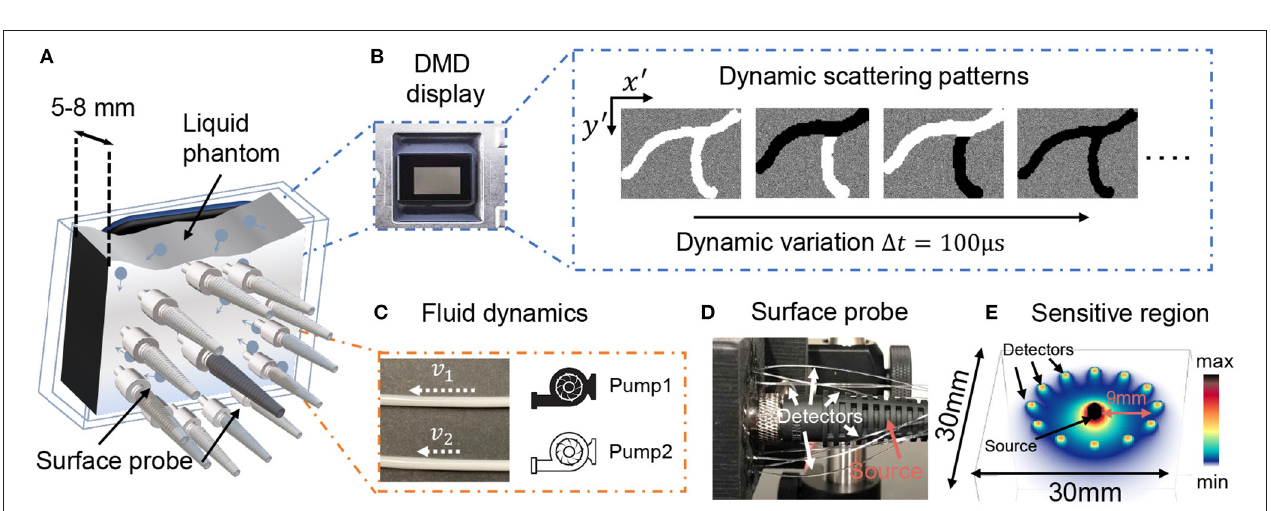
FIGURE 2 | (A) Illustrates the tissue phantom used. Light from 12 different surface positions were collected with multimode fibers placed circularly around the center source. (B,C) Two different mechanisms we used to generate perturbed decorrelation phenomena. (B) A DMD pane hidden underneath the liquid phantom, flipping at multi-kilo hertz rate. (C) Scattering liquid contained in 3 mm transparent plastic tubes, flowing at constant speeds. (D) Photo of PaDS probe. (E) Monte Carlo simulation of the light propagation